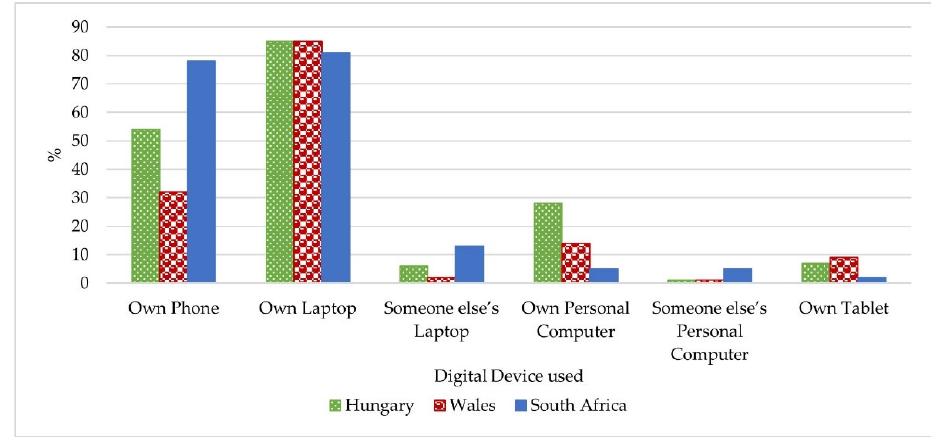
Figure 14. Digital device used for online learning (%).